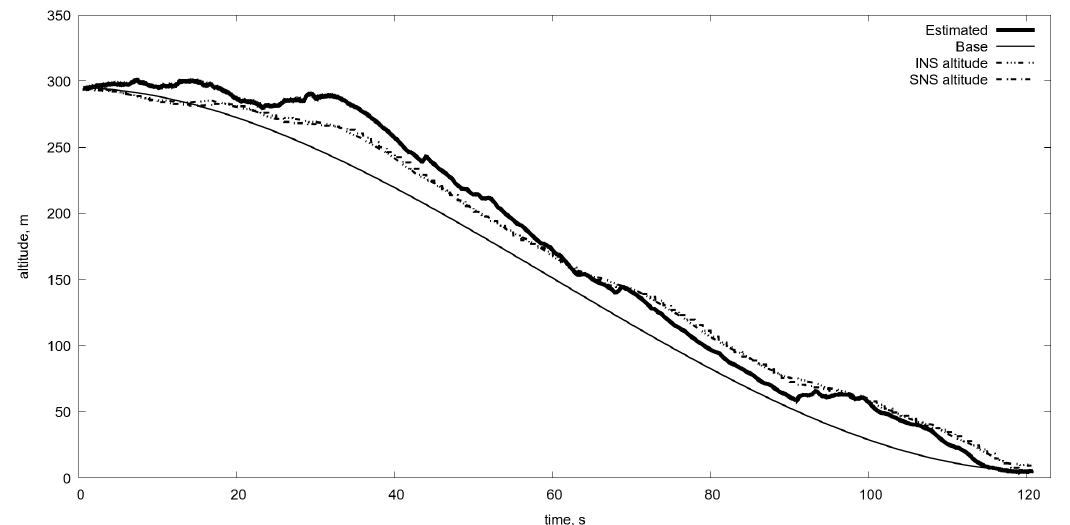
Figure 11. Estimated altitude in comparison with the real one obtained with the aid of averaging algorithm parameters described in Table 1. Estimated is the altitude obtained by optical flow and Kalman filtering. Base is the program motion. INS is the altitude from the inertial navigation system. SNS is the altitude from the satellite navigation